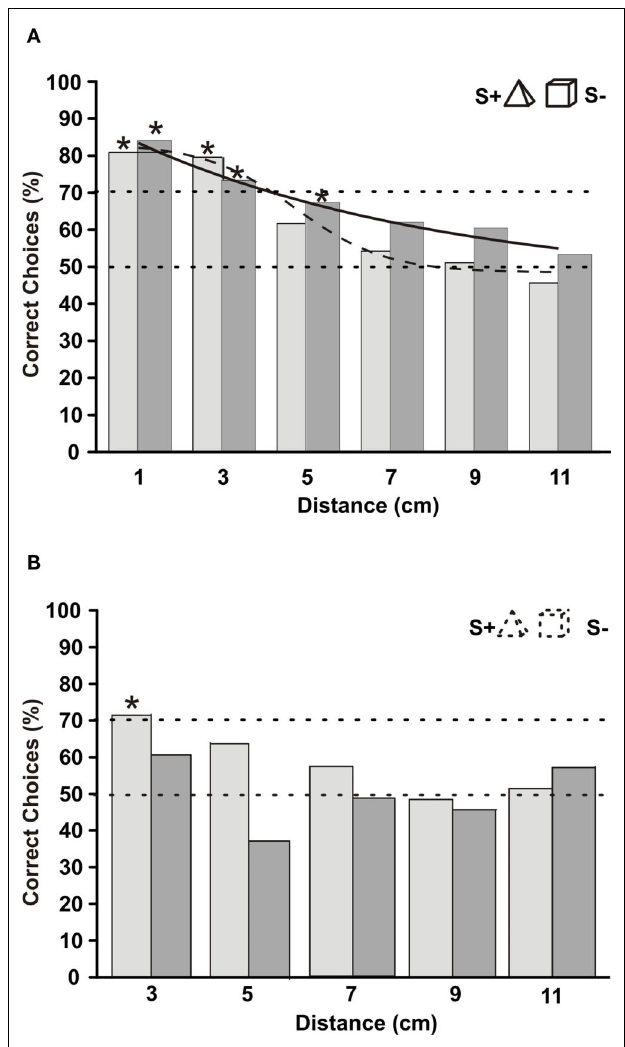
FIGURE 8 | (A) Mean choice frequencies of fi sh 3, which was trained to discriminate between a pyramid (S + ) and a cube. Both objects were made from clay and were painted with varnish, which sealed them to water. Objects were placed at different distance from their gates (abscissa). Fish were tested either with visible lights on (light grey columns), or in complete darkness (infrared illumination; dark grey columns). Sigmoid curves were fi tted to the two data sets (solid line = dark conditions, dashed line = lights on) N > 45. (B) Same as in (A) but with clay objects, which were not painted and therefore were soaked with water. This hampered their detection through active electrolocation. Dots within each column give mean choice latencies with standard deviation (right ordinate). N >